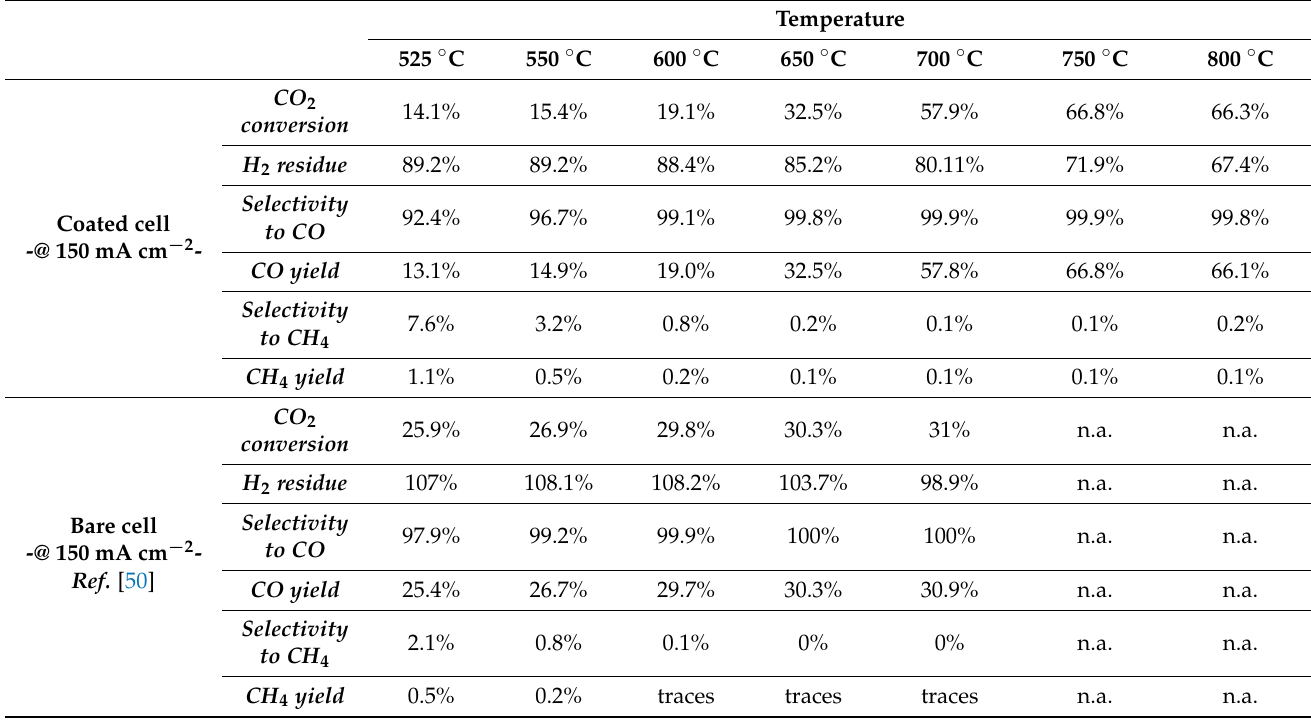
Table 2. Most relevant chromatographic data achieved with bare and coated